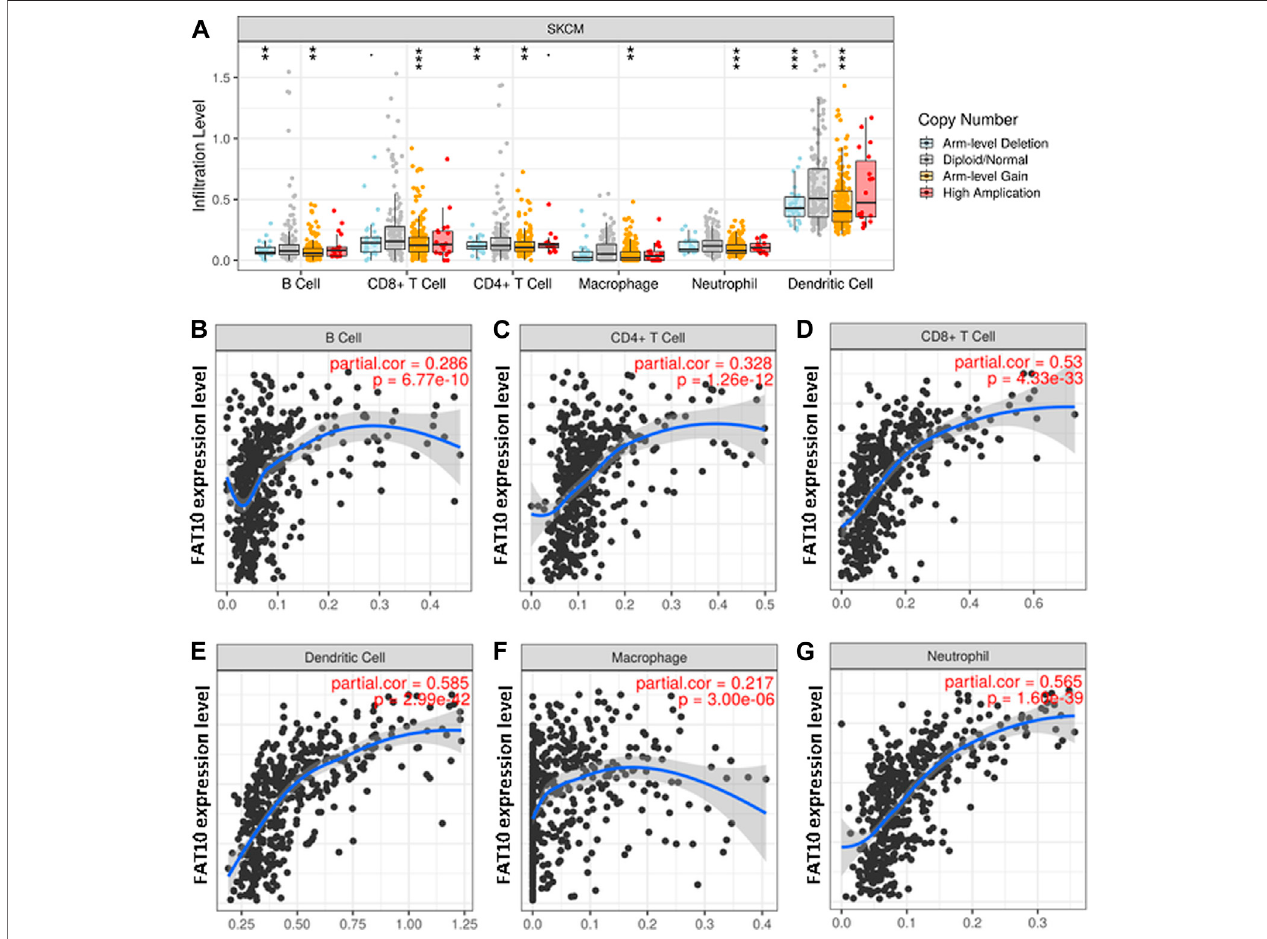
FIGURE6| The relationshipbetweenimmunecellin fi ltration and FAT10 level inSKCM. (A) The in fi ltration level ofvarious immune cells in SKCM withdifferentcopy numbersofFAT10. (B – G) FAT10expressionlevelandBcells (B) ,CD4 + Tcells (C) ,CD8 + Tcells (D) ,dendriticcells (E) ,macrophages (F) ,orneutrophils (G) correlationof in fi ltration level in